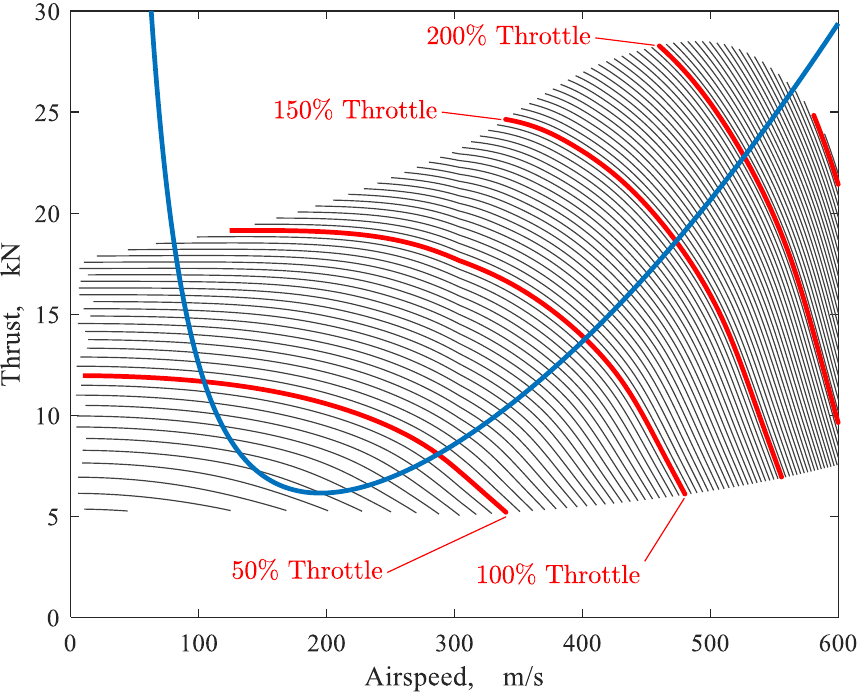
Figure 6. Thrust required (blue line) for cruise for F-5E airframe overlaid on twin turbojets perfor- mance envelope (thrust versus fuel flow rate). Altitude = 9 km.